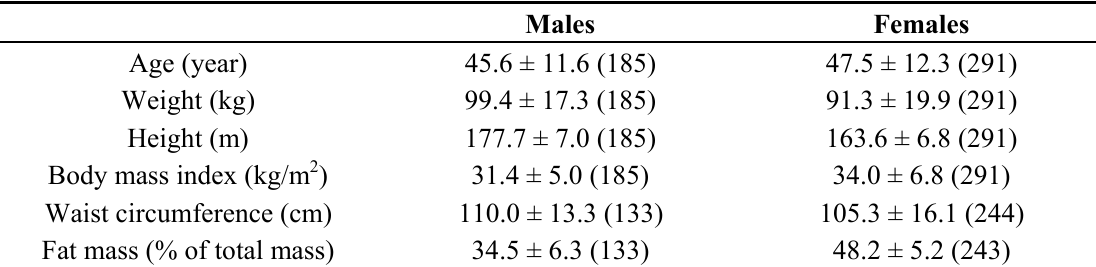
Table 1. Participant characteristics